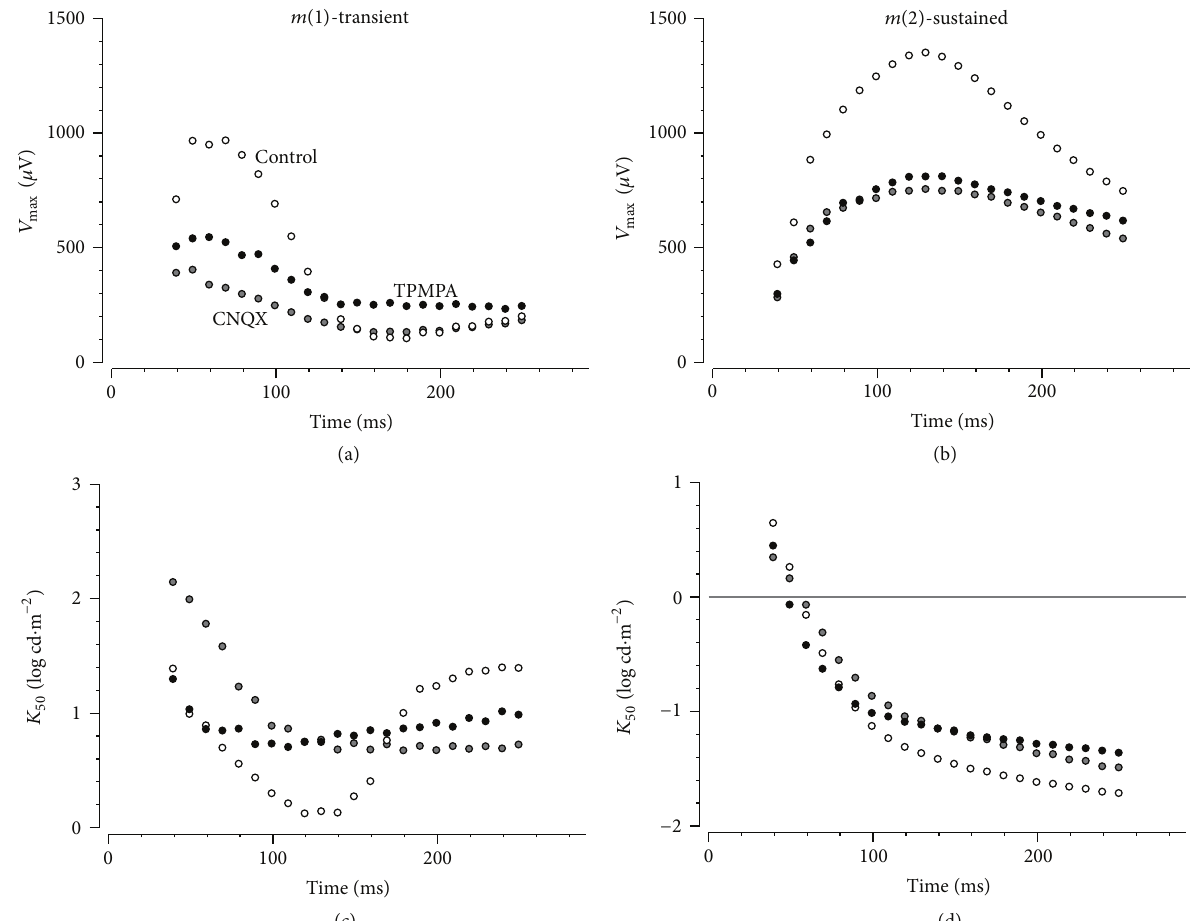
Figure 6: Effect of CNQX or TPMPA on rat PII during a light step. Optimized parameters 𝑉 max ((a) and (b)) and 𝐾 50 ((c) and (d)) for controls (unfilled symbols), CNQX (grey), and TPMPA treated (black symbols). Left panels show the transient mechanism ( 𝑚 ( 1 )), whereas the right panels show the sustained mechanism ( m ( 2